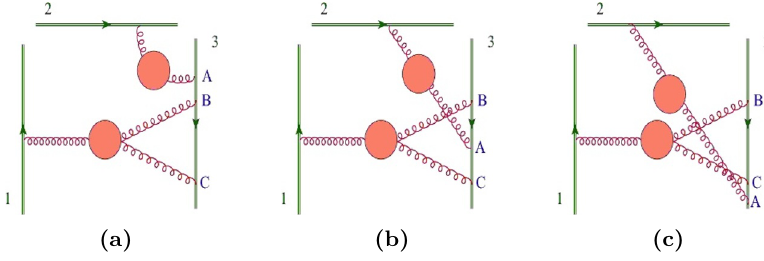
Figure 11. The three skeleton diagrams contributing to W (1 , 1)